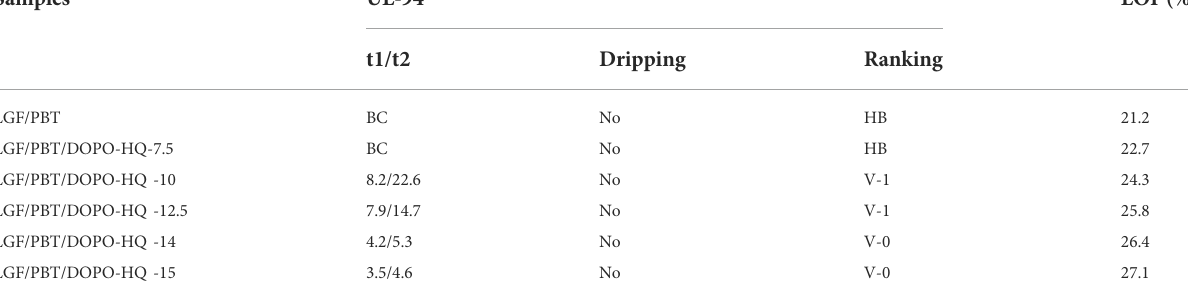
TABLE 1 The fl ame-retardant properties of LGF/PBT/DOPO-HQ-conjugated fl ame-retardant composites.